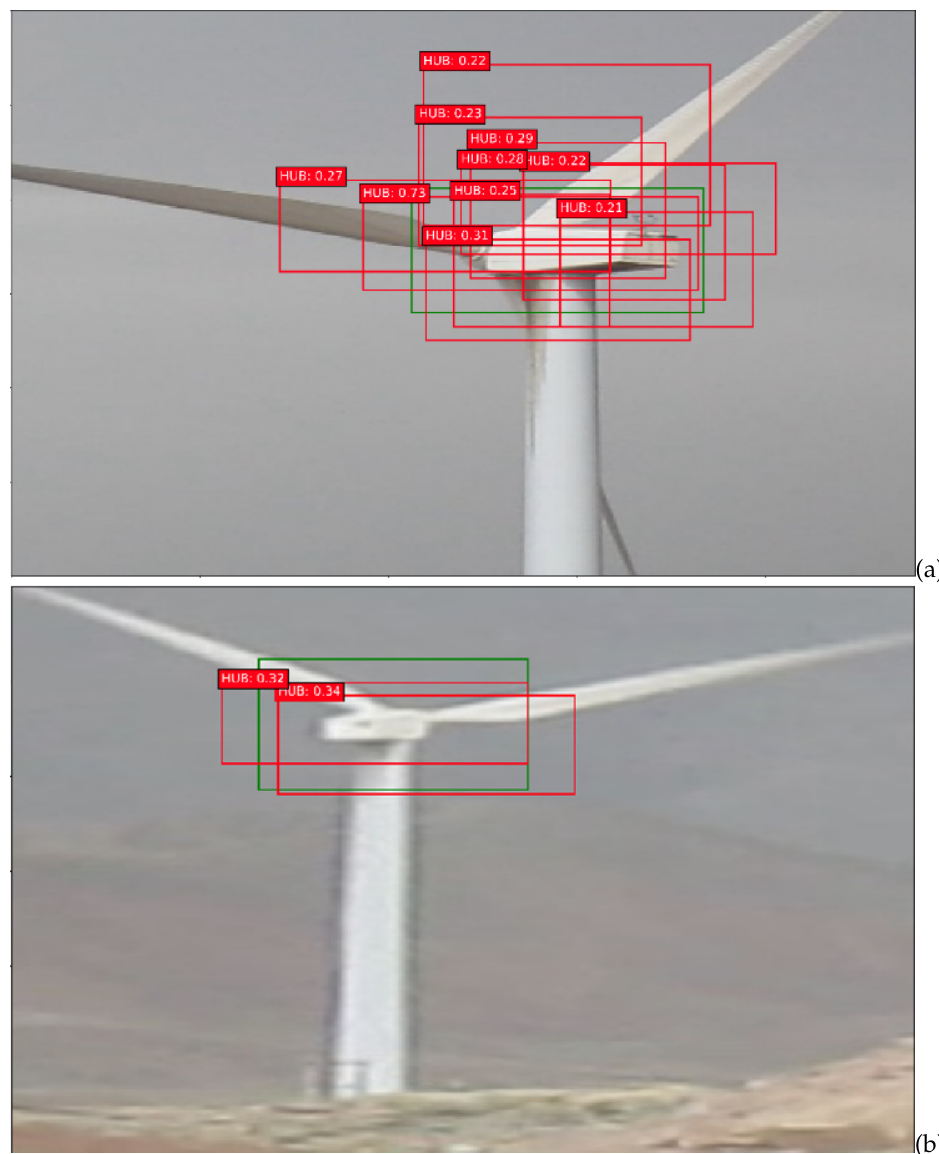
Figure 10. Detection of the hub with different accuracies without NMS (Green box: Ground truth box). ( a ) A near-field sample ( b ) A far-field